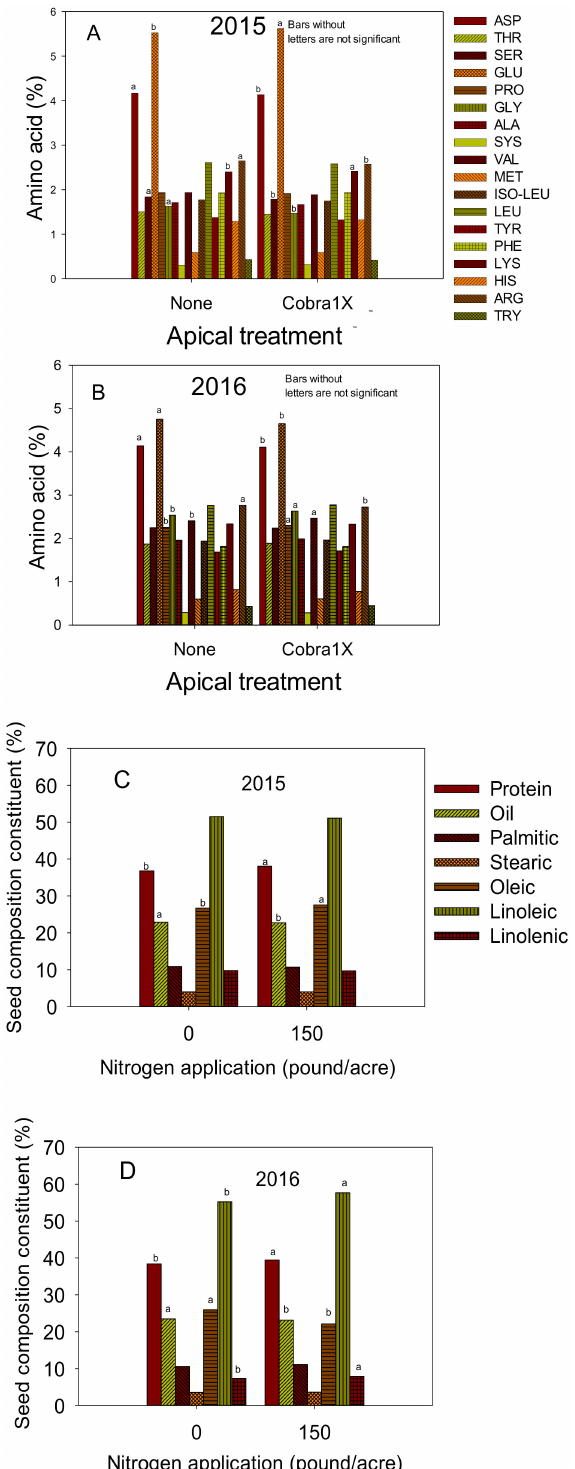
Figure 2. E ff ect of apical treatment of Cobra1X (rate of 12 oz / ac = 0.88 L ha − 1 ) on seed amino acids (%) in 2015 ( A ) and 2016 ( B ); E ff ect of nitrogen (N) application at rate of 0 or 150 lbs N ac − 1 (0 or 168 kg ha − 1 ) on seed protein, oil, and fatty acids palmitic, stearic, oleic, linoleic, and linolenic (%) in 2015 ( C ) and 2016 ( D ). Bars with the same colors and patterns with di ff erent letters are significantly di ff erent at P ≤ 0.05. Bars without letters are not